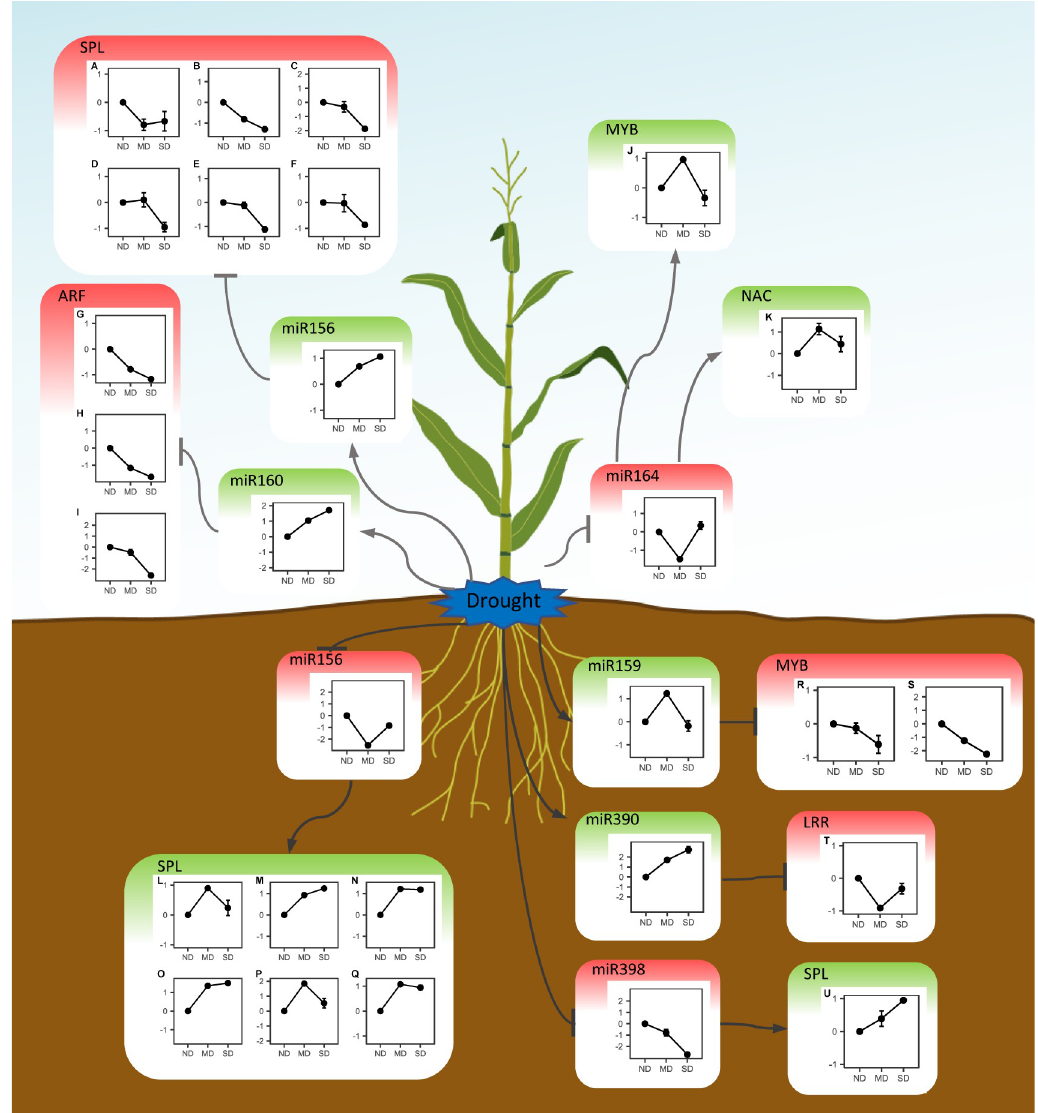
Fig 4. Regulation networks of drought-responsive miRNAs and their target mRNAs. The left and right panel include the miRNA-mRNA expression in Lv28 and H082183 respectively. (A) GRMZM2G065451, (B) GRMZM2G113779, (C) GRMZM2G414805, (D) GRMZM2G126018, (E) GRMZM2G371033, (F) GRMZM2G067624, (G) AC207656.3_FGT002, (H) GRMZM2G390641, (I) GRMZM2G159399, (J) GRMZM2G096358, (K) GRMZM2G114850, (L) GRMZM2G113779, (M) GRMZM2G160917, (N) GRMZM5G806833, (O) GRMZM2G307588, (P) GRMZM2G460544, (Q) GRMZM2G061734, (R) GRMZM2G004090, (S) GRMZM2G028054, (T) GRMZM2G304745, (U) GRMZM2G103812. The y-axis shows the log 2 (fold change) of miRNAs or mRNAs under drought. The x-axis presents the water treatment conditions. ND: well-watered treatment, MD: moderate drought, SD: severe drought.